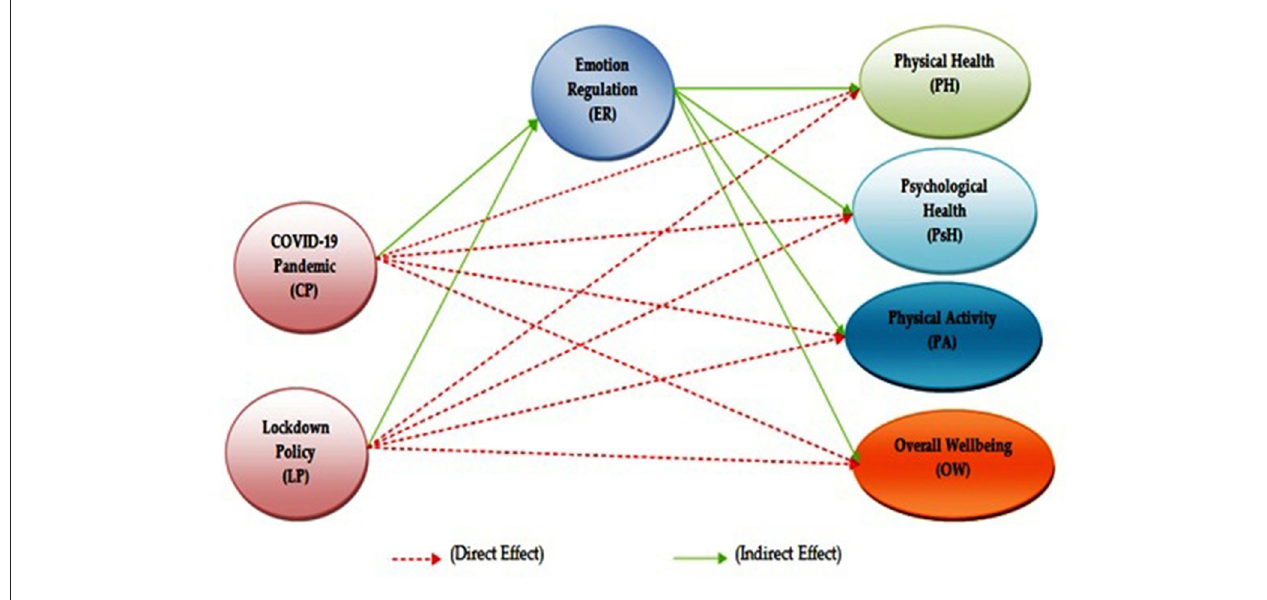
FIGURE 3 | Factor loadings, path coefficient, and R-square result (PLS-algorithm).